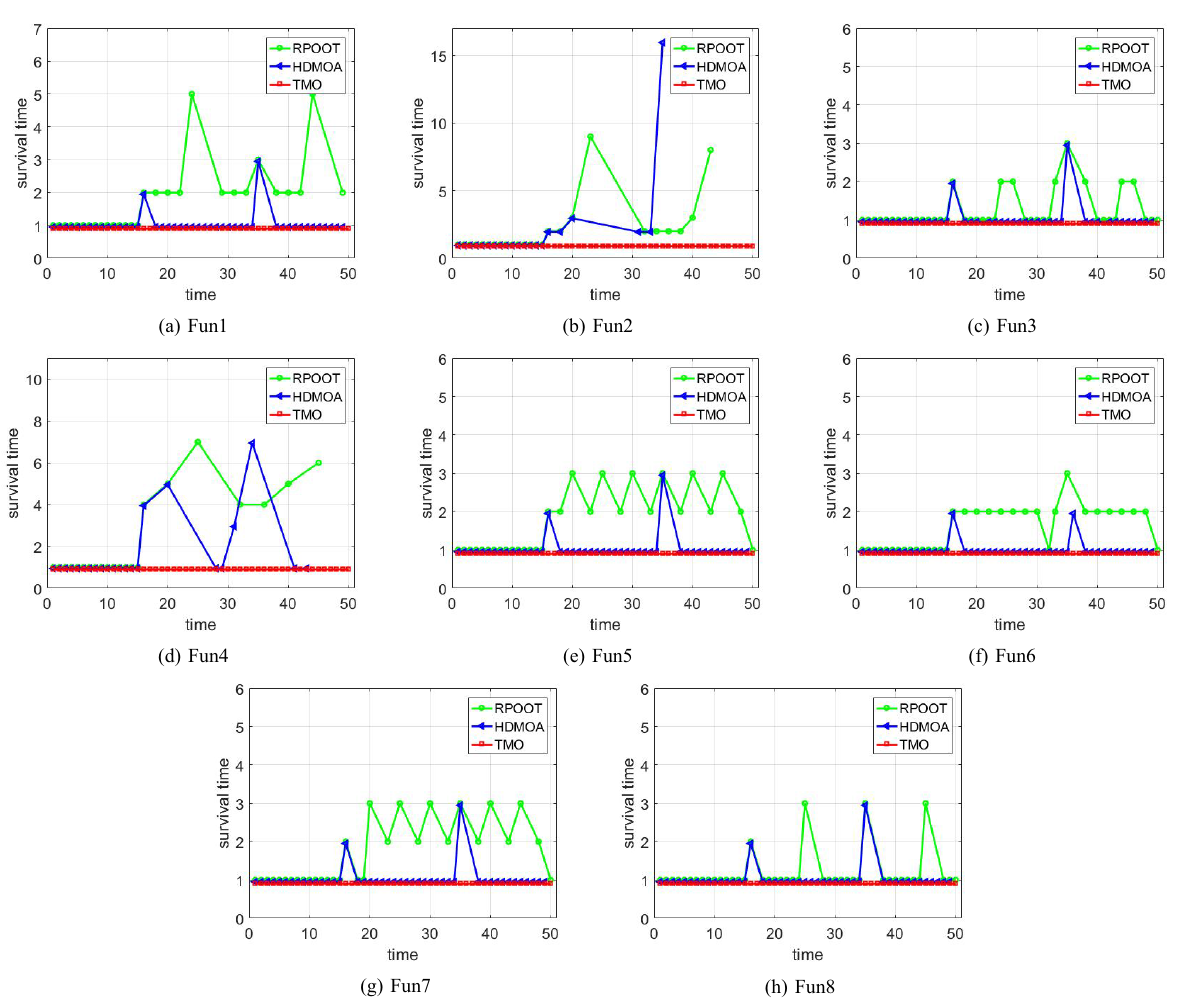
Fig. 5 Survival time comparison of three methods under linear environmental